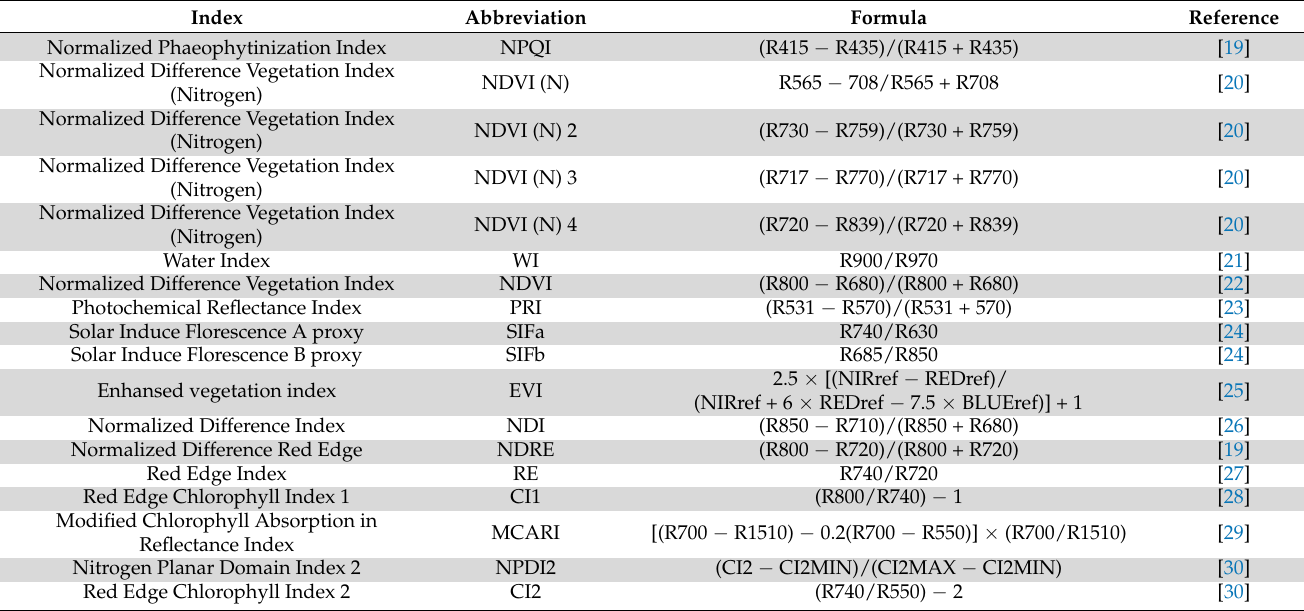
Table 1. Selected vegetation indices in the